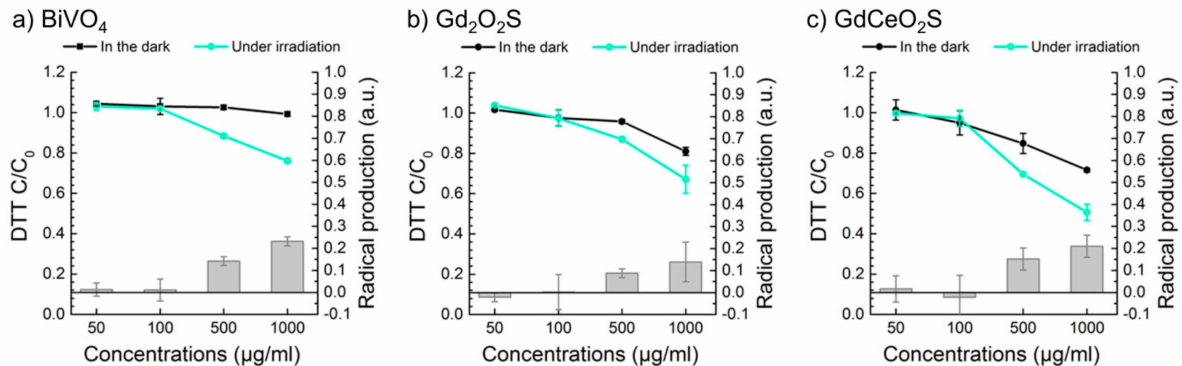
Figure 3. Radical production under irradiation of 501 nm visible light of ( a ) BiVO 4 nanoparticles, ( b ) Gd 2 O 2 S ( x = 0%) nanoparticles and ( c ) GdCeO 2 S ( x = 50%) nanoparticles at different concentra- tions of photocatalysts. Radical production under irradiation, calculated as difference between the normalized DTT quantities in the dark and under irradiation, is presented as bar graph (right y -axis). Under irradiation, the DTT amount decreased significantly further (cyan dots). At